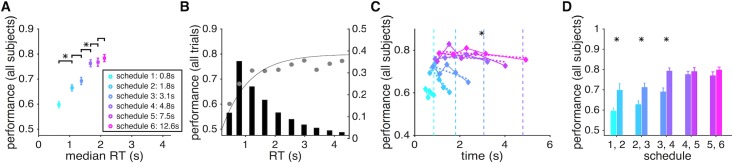
Dynamic combination of sensory and reward information was affected by time pressure and revealed that subjects were sensitive to imperfect sensory integration.(A) Subjects improved their performance with longer integration time, and their performance reached a plateau in less than 2.0s. The average performance (probability of a correct response) is plotted as a function of the average median response time (RT) across all subjects, separately for trials with a given level of time pressure (the average available time for each schedule is noted in the legend). Conventions are the same as in Fig 2. (B) Performance increased with longer RT but plateaued at ~1.25s. Performance is plotted as a function of RT binned in ten equal intervals. The solid curve shows the fit using a modified Weibull function. The histogram shows the distribution of RT across the ten bins. (C) Performance did not improve and plateaued closer to the deadline (except for schedule 3 where it declined closer to the deadline) for a given level of time pressure. For display purposes, only four of the six deadlines are shown. (D) Even with equal accumulation time, performance was reduced with more time pressure. Plotted is the average performance on RT-matched trials (based on mean) with adjacent levels of time pressure.